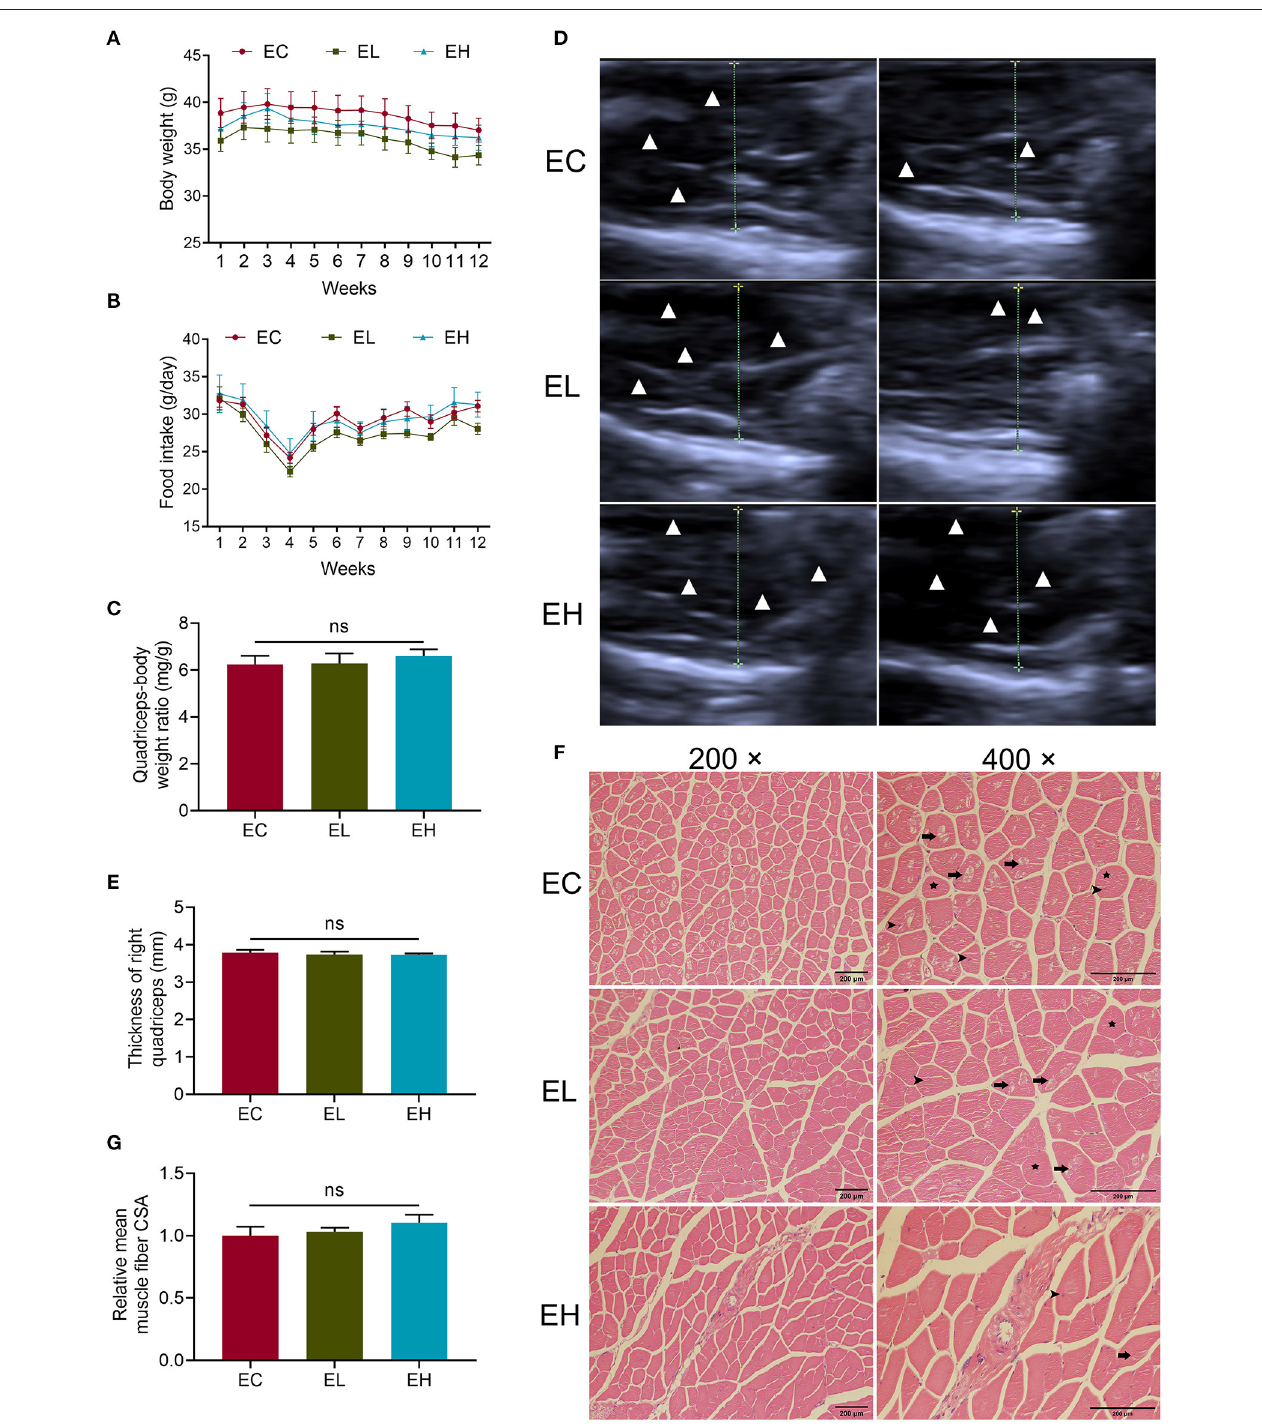
FIGURE 2 | Phenotype changes after leucine supplementation in aging mice. (A,B) Body weight and food intake variation throughout the experiment; (C) quadriceps-body weight ratio in endpoint groups; (D,E) the quadriceps ultrasonographic images as well as muscle thickness of right quadriceps in endpoint groups. Muscle fiber appeared hypoechoic, while perimysium and fascia appeared hyperechoic. White triangles represented hypoechoic areas while the dotted lines showed the transverse diameters of quadriceps; (F) H&E staining sections of quadriceps in endpoint groups, scale bar: 200 µ m. Long arrows pointed to vacuolization, stars represented rounding and short arrows pointed to nuclei ingression in muscle fibers. (G) Relative mean muscle fiber cross-sectional area (CSA) in the endpoint groups. ns, no significance.